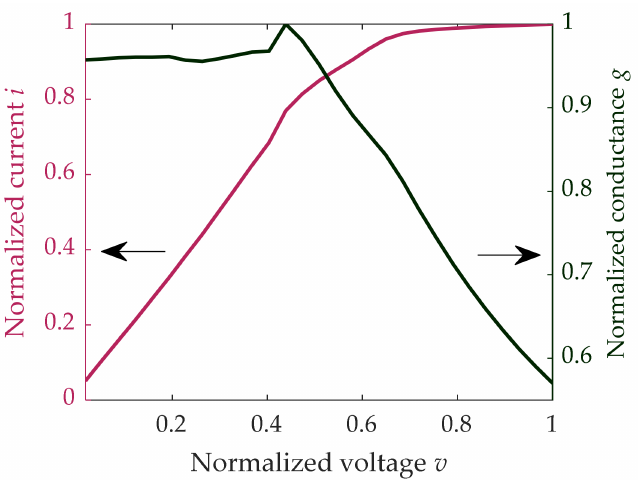
Figure 4. Left axes: typical normalized I-V characteristic obtained by averaging the currents of 5120 cells. Right axes: normalized cells mean conductance g =